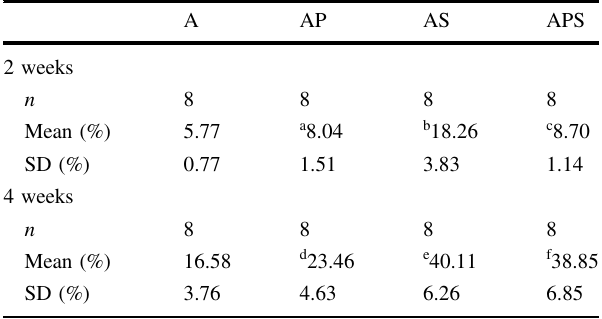
Table 1 New bone rates in